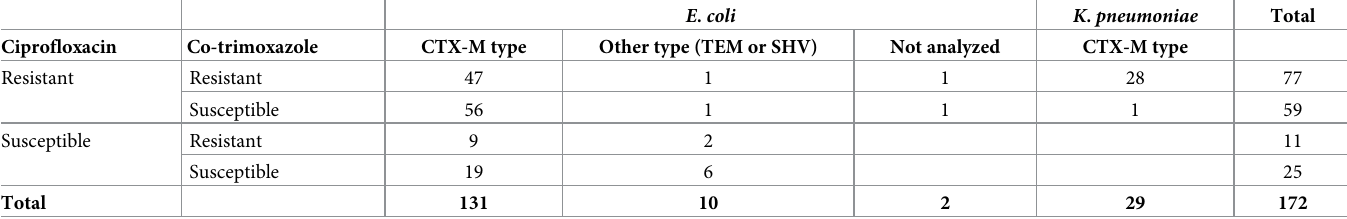
Table 3. Distribution of co-resistance to ciprofloxacin and/or co-trimoxazole among extended spectrum beta-lactame (ESBL) producing Escherichia coli and Klebsi- ella pneumoniae isolates in 29 Belgian nursing homes,